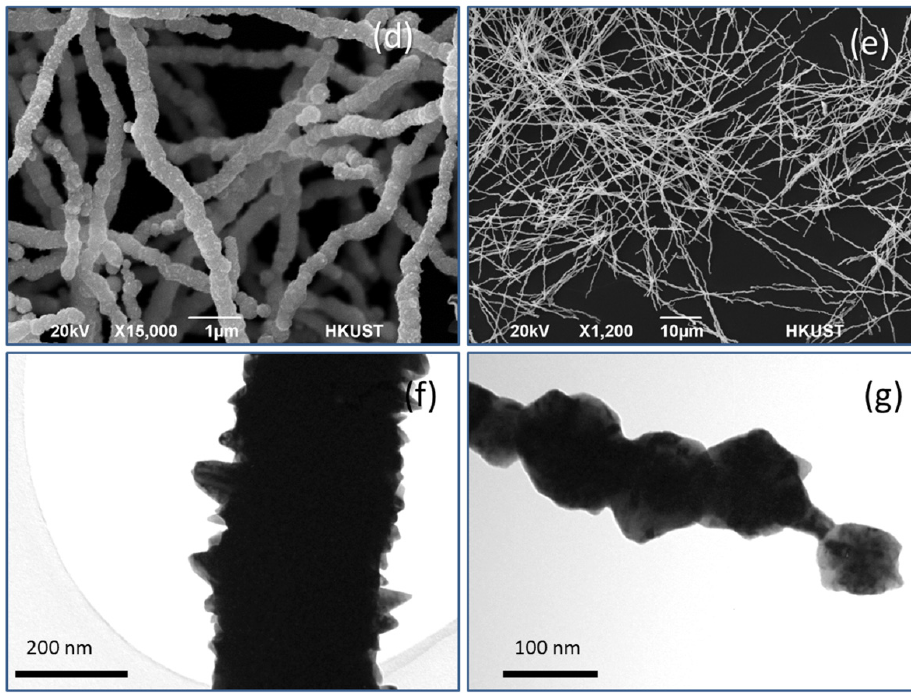
Figure 1. The photographs of nickel nanowires (NiNWs) ( a ) dispersed in ethanol ( b ) attracted by an external magnet, ( c ) X-ray diffraction (XRD) patterns, ( d ) low and ( e ) high magnification scanning electron microscopy (SEM) images of NiNWs; and the transmission electron microscopy (TEM) images of ( f ) the body and ( g ) the end of a NiNW.